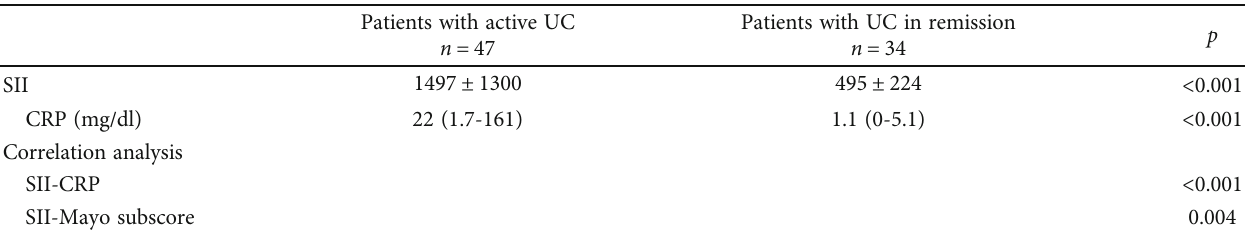
Table 2: Correlation analysis and comparison of laboratory fi ndings between the patients with active ulcerative colitis and ulcerative colitis in